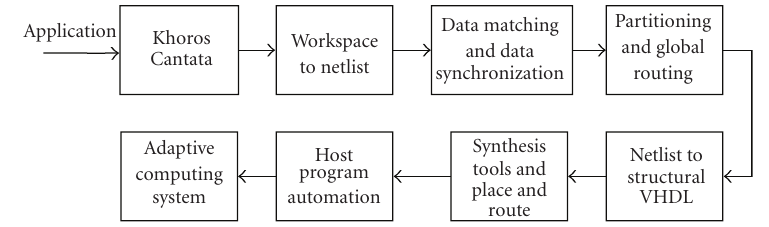
Figure 1: Overview of the design flow of CHAMPION.